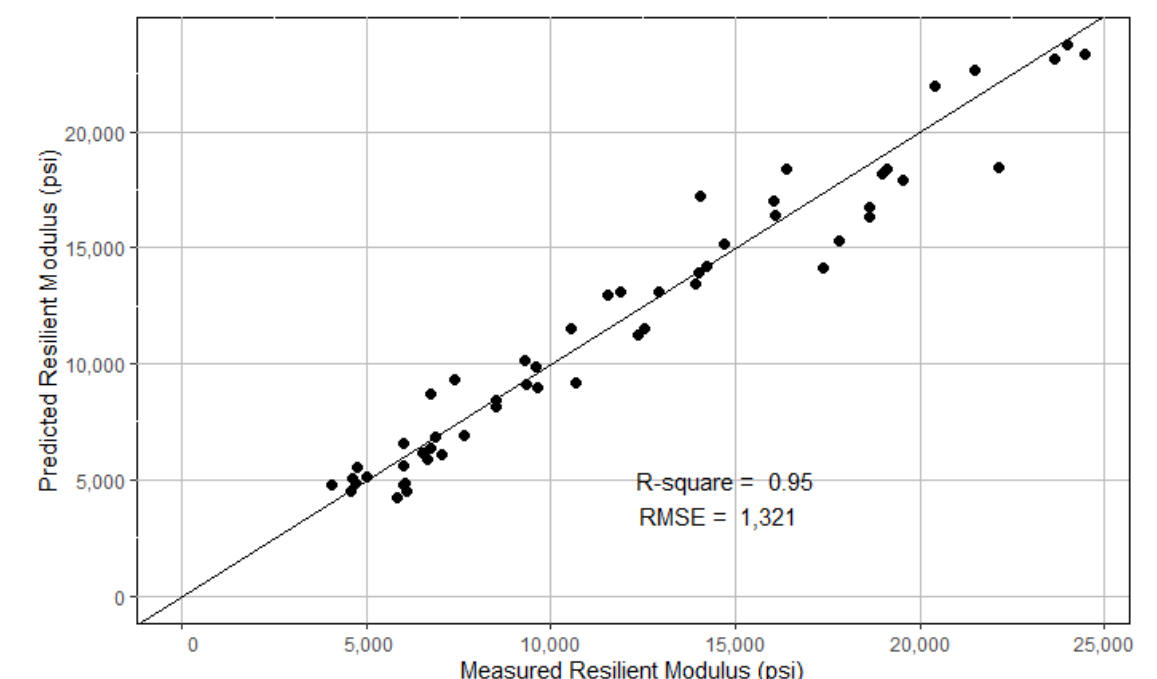
Figure 9. Predicted M R versus measured M R on testing dataset (the XGBoost model).